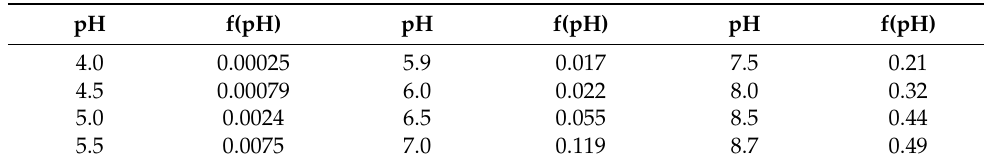
Table 2. Values of function f at different pH.